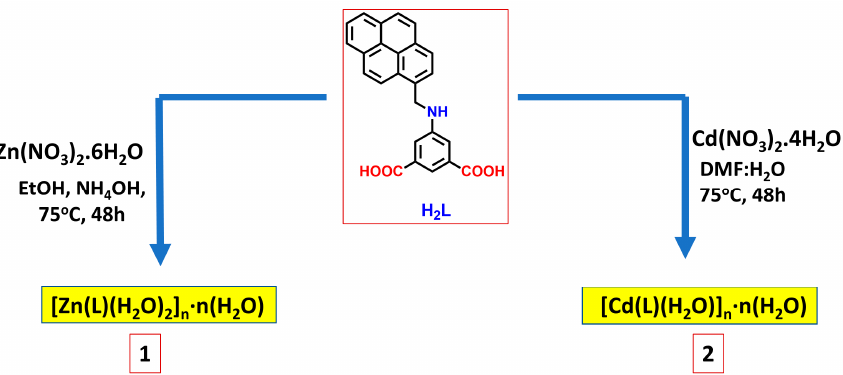
Figure 1. Synthesis of coordination polymers 1 and 2 by reactions of H 2 L and Zn(NO 3 ) 2 · 6H 2 O or Cd(NO 3 ) 2 · 4H 2 O, under solvothermal conditions.